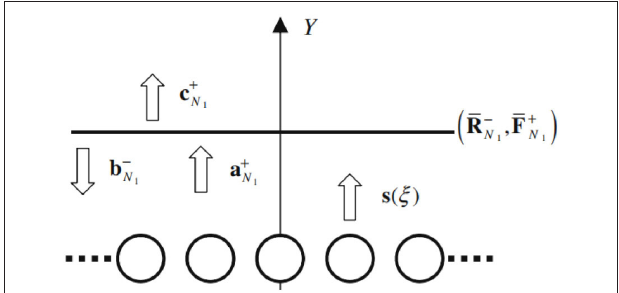
FIGURE 3 | Multiple scattering processes of space harmonics mainly radiated from the periodic array of line sources. The plane boundary characterized by the generalized reflection and transmission matrices R − N of the photonic crystals.